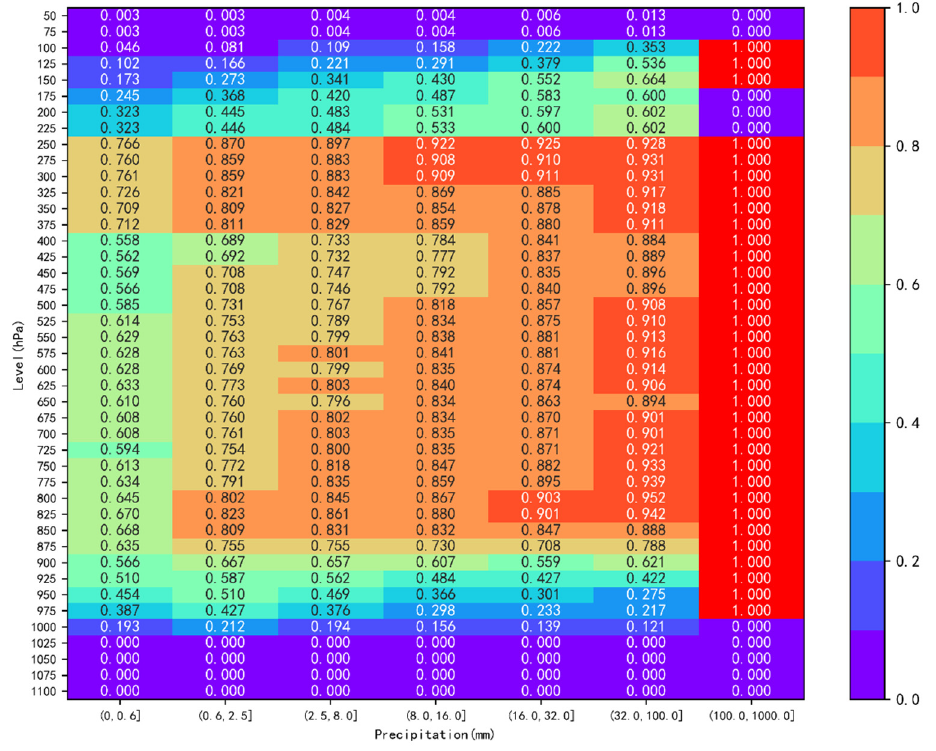
Figure 7. Proportional fit of cloudiness at each level to surface precipitation at different intervals.